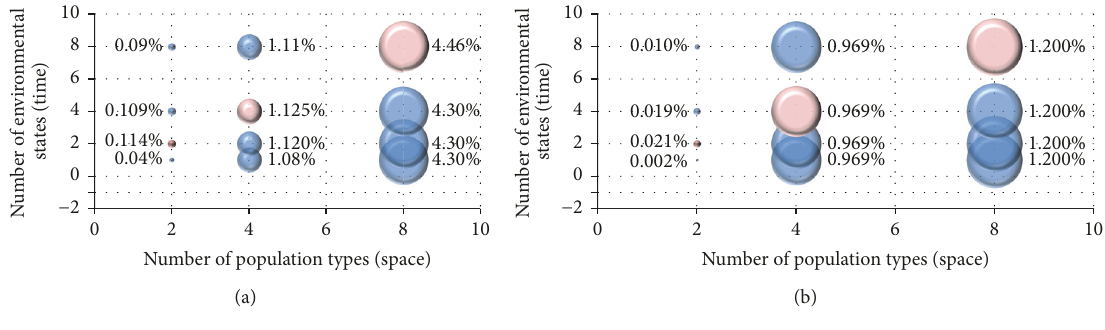
𝑒,𝑔 𝑒,𝑔 𝑒,𝑔 𝑊 = 𝑊 − 𝑊 . (a) Japanese exports (as reported in Figure 5); (b) North SC CS ( emp ) 𝑒,𝑔 𝑊 perpopulationsplit(verticalalignment)